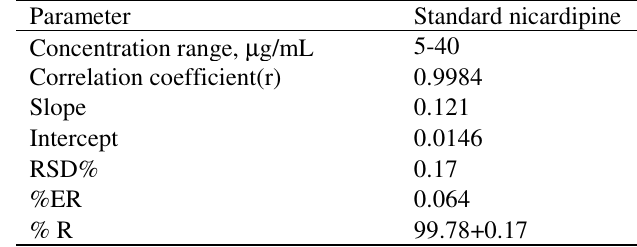
Table 2. Effect of concentration of sodium hydroxide on the kinetic parameters of nicardipine HCl (40 µ g/mL) at room